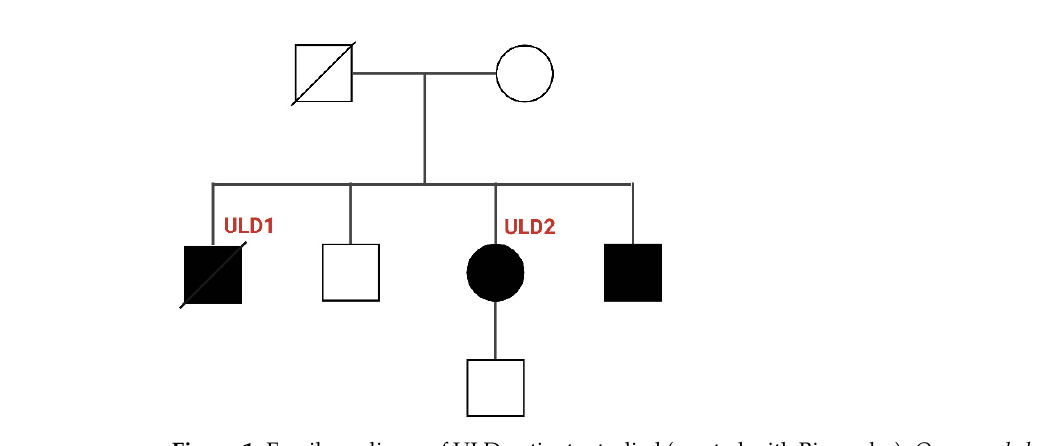
Figure 1. Family pedigree of ULD patients studied (created with Biorender). Open symbols : unaffected individuals, solid symbols : affected individuals, squares : males, circles : females, symbols with a diagonal line : deceased. Table 1. Summary of the clinical features, treatment and genetic mutation of ULD1 and ULD2